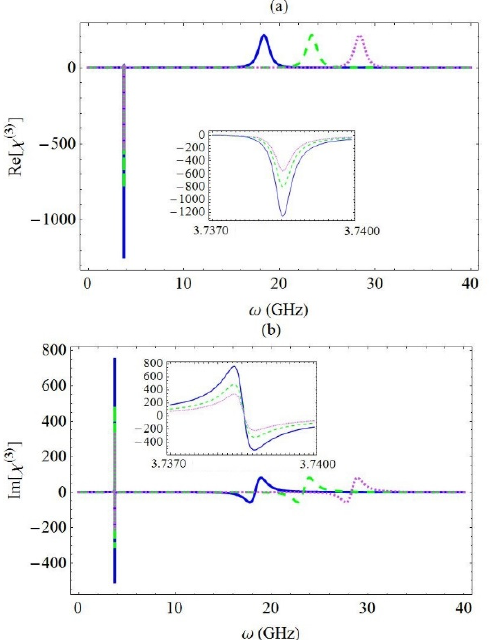
, respectively. In addition, the exciton–phonon coupling strength g was equal to 10 GHz , as in the case of the (1) χ spectra presented in Figure 4. Since the value of the fundamental phonon mode ω was not modified, the position of this resonance did not n / ω ω ω= + g was transposed practically change. However, the resonance arising at 2 n 10 to the right when the exciton resonance frequency is increased, since its position presented ω parameter. Hence, equally spaced values of the exciton linear dependence on the 10 ω in- energy led to a set of equidistant spectral peaks. We also observed that when (3) χ Figure 5. The real part ( a ) and the imaginary part ( b ) of χ ( 3 ) , for different values of the coupling 10 Figure 5. The real part ( a ) and the imaginary part ( b ) of , for different values of the coupling creased, the amplitude of the sharp resonance decreased at a decelerating rate, whereas strength between the exciton and the phonon mode: g = 5 GHz (blue solid curve), 10 GHz (green strength between the exciton and the phonon mode: 5 GHz = g (blue solid curve), 10 GHz the amplitude of the broader resonance remained intact. dashed curve), and 15 GHz (magenta dotted curve). In addition, ω 10 = 10 GHz. 10 GHz ω = . (green dashed curve), and 15 GHz (magenta dotted curve). In addition, 10